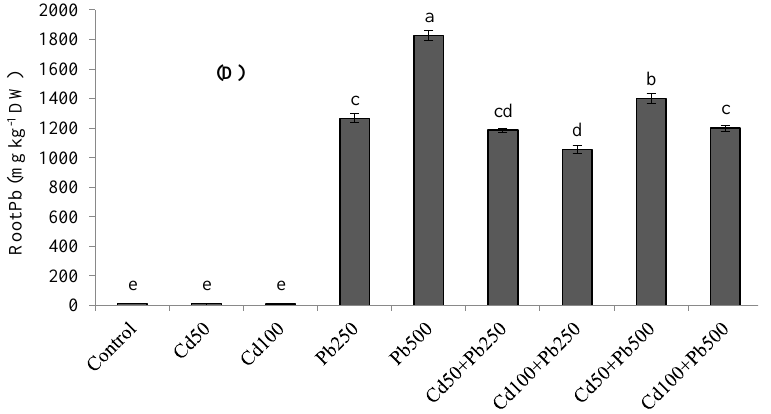
Figure 4. Effect of different levels of Cd, Pb and their combinations on Cd concentration in shoot ( A ), root ( B ) and Pb concentration in shoot ( C ) and root ( D ) of quinoa. Different letters represent the significant difference among the treatments at a 5% significance level. Table 3. Bioconcentration factor (BCF), translocation factor (TF) and tolerance index (TI) of quinoa plants exposed to various concentrations of cadmium and lead under hydroponic conditions. Cd Pb